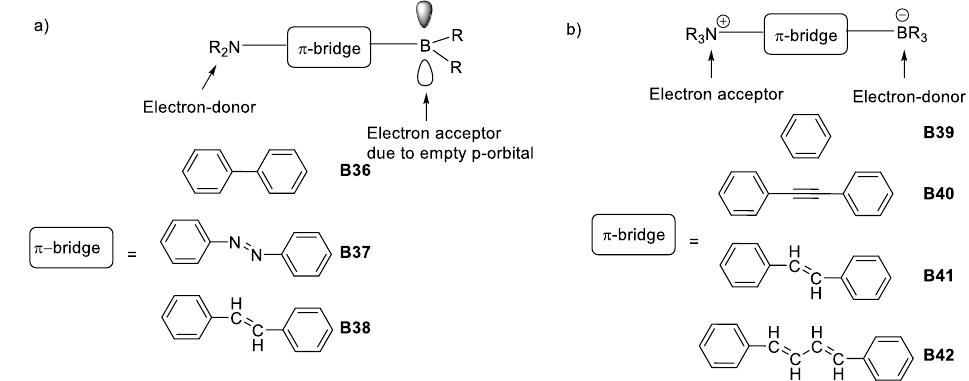
Figure 21. Boron-based architectures searched for NLO properties during the early 90s. ( a ) Dipolar design varying π-bridges with trivalent boron as electron acceptor unit; ( b ) dipolar architecture varying π-bridges with tetravalent boron as donor unit.